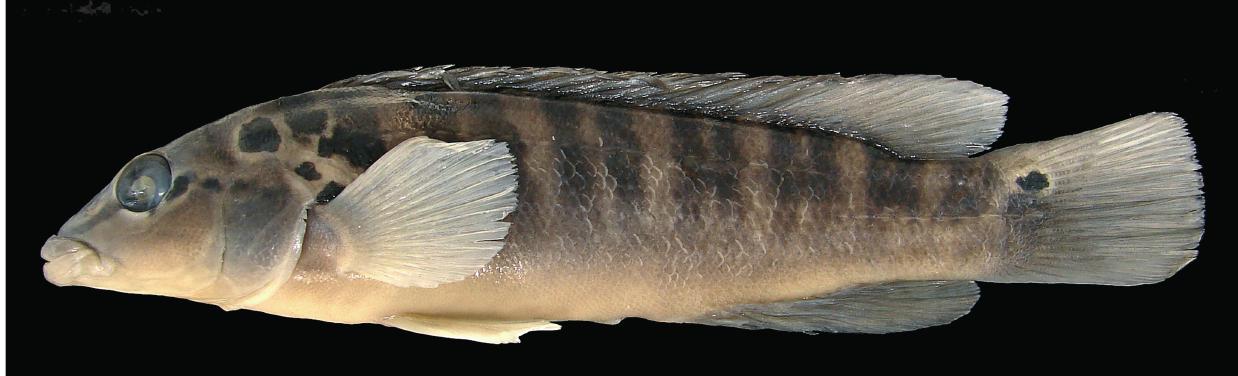
Fig. 1 . Crenicichla hadrostigma , holotype, rio Chapecó, Coronel de Freitas, Santa Catarina, MCP 40959 (100.1 mm SL, male).